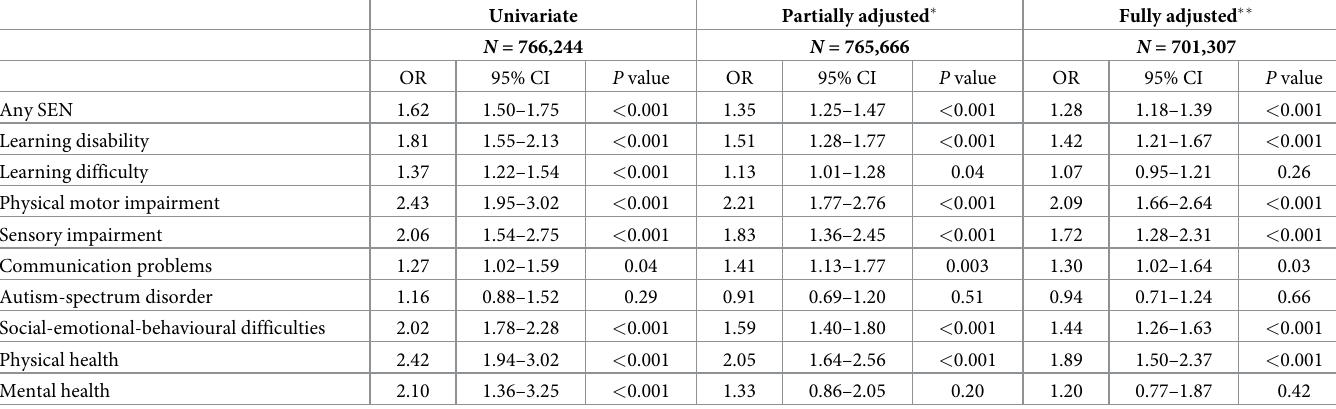
Table 2. Associations between previous hospitalisation for traumatic brain injury and special education